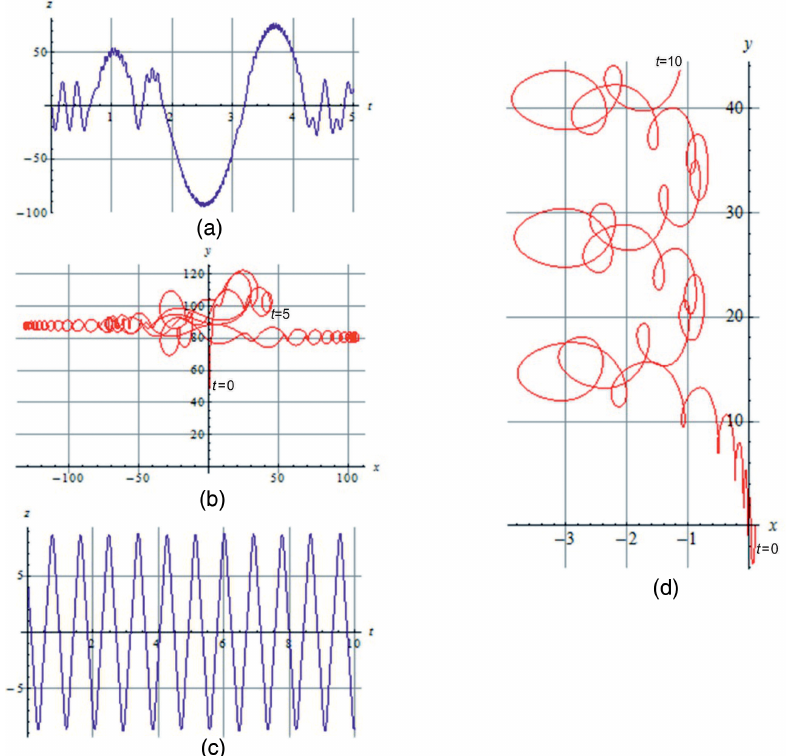
Figure 6. (a) Oscillations over z on the “cucumber” orbit. (b) The “cucumber” orbit projected to the z = 0 plane. (c) Oscillations over z on the “ring” orbit. (d) The “ring” orbit projected to the z = 0